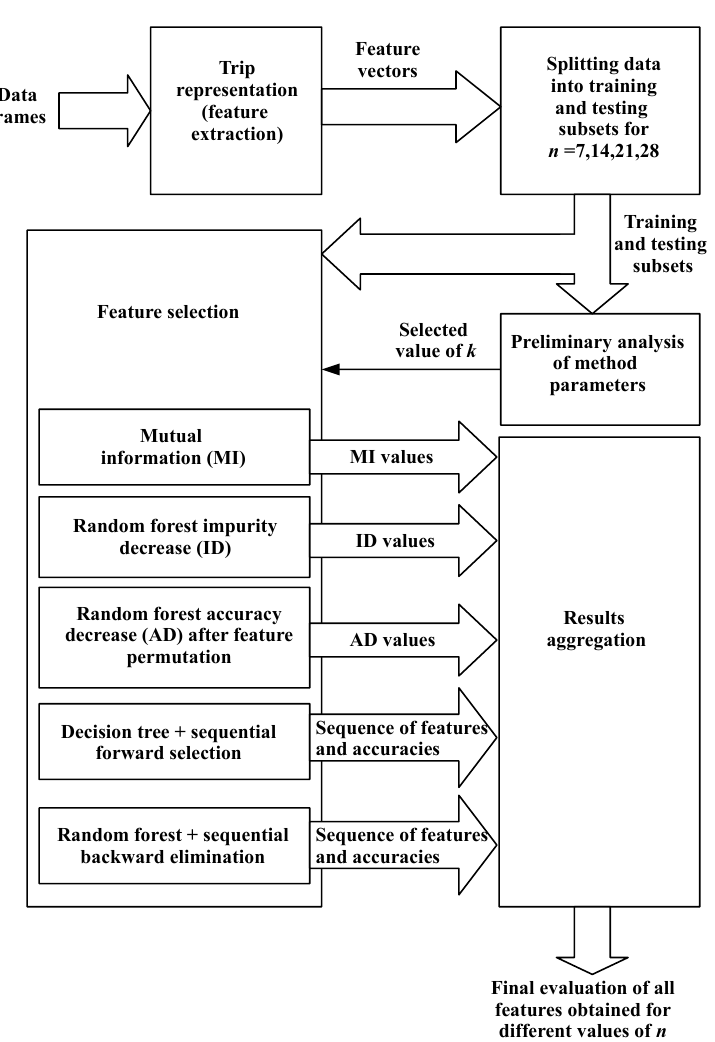
Figure 2. The process of feature